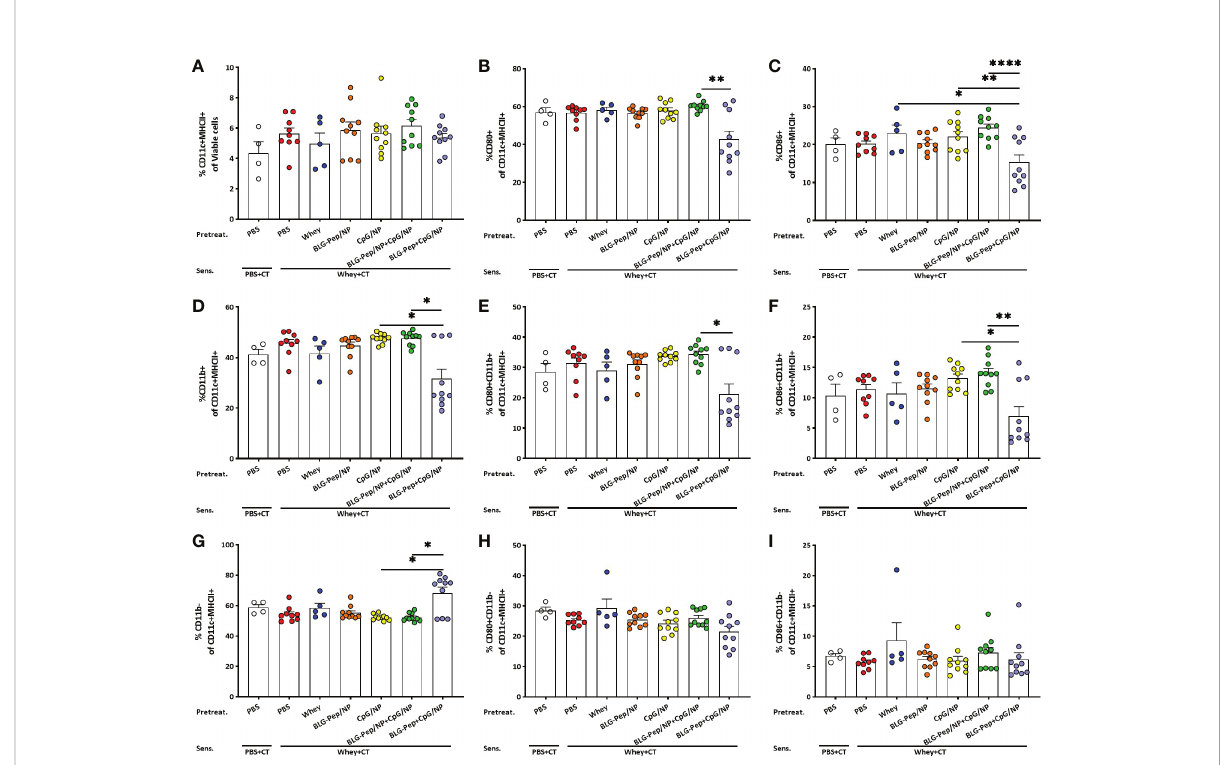
FIGURE 3 Surface activation markers expression on dendritic cells in mesenteric lymph nodes (MLN). Eighteen hours after oral whey-sensitization, MLN cells were isolated and analyzed using fl ow cytometry to determine the percentage of CD11c+MHCII+ DC (A) and CD11b+ (D) and CD11b- (G) DC subsets. Surface costimulatory molecules expression of CD80+ (B, E, H) and CD86+ (C, F, I) on CD11c+MHCII+ DC, CD11b+ and CD11b- DC subsets were determined respectively. Data are presented as mean ± SEM for n=9-10 per group except for the sham group, n=4 and whey-tolerant group, n=5. (A) is analyzed with one-way ANOVA for selected pairs after log transformation, followed by Bonferroni ’ s post hoc test; (B) and (D – I) are analyzed with the Kruskal-Wallis non-parametric test, followed by Dunn ’ s post hoc test for selected pairs; (C) is analyzed with one-way ANOVA for selected pairs after log transformation, followed by Bonferroni ’ s post hoc test; * p <0.05, ** p <0.01; CT, Cholera toxin.